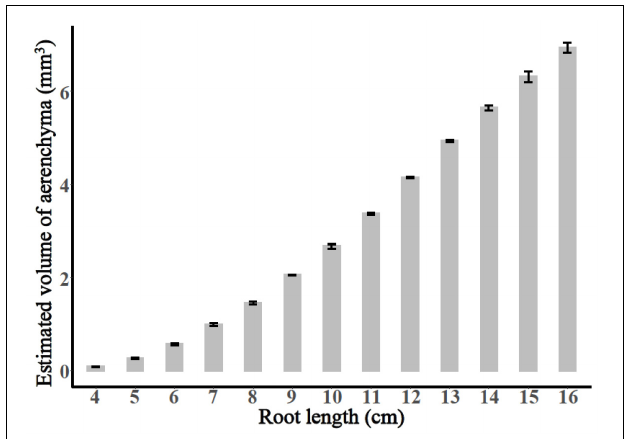
FIGURE 7 | The calculated total volume of aerenchyma of the adventitious roots with different